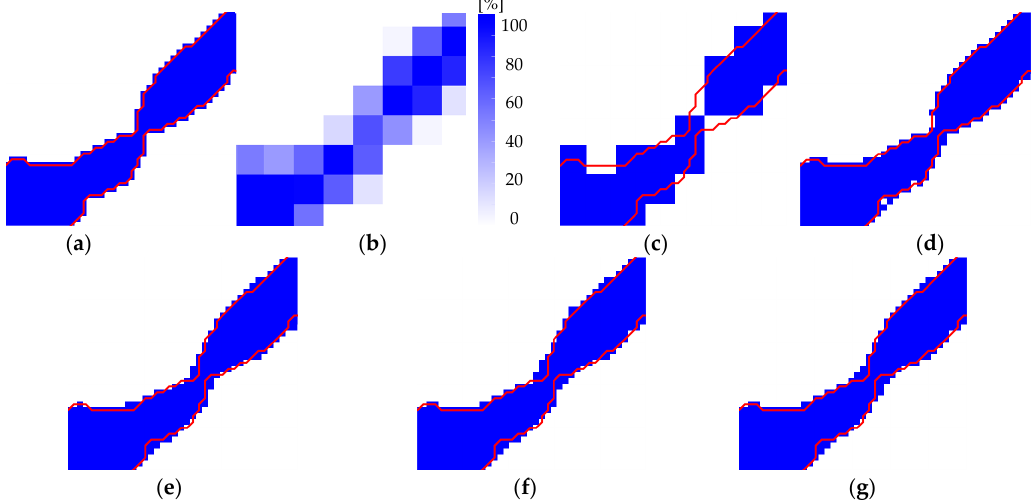
Figure 15. Sub-pixel maps resultant from different super-resolution mapping (SRM) algorithms using semi-simulated water fractions: ( a ) reference map, ( b ) semi-simulated water fractions ( ZF = 5), ( c ) hard classified map, sub-pixel maps of ( d ) PS, ( e ) bilinear, ( f ) bicubic, and ( g ) lanczos3 algorithms; reference river boundaries are represented by red lines on each map.